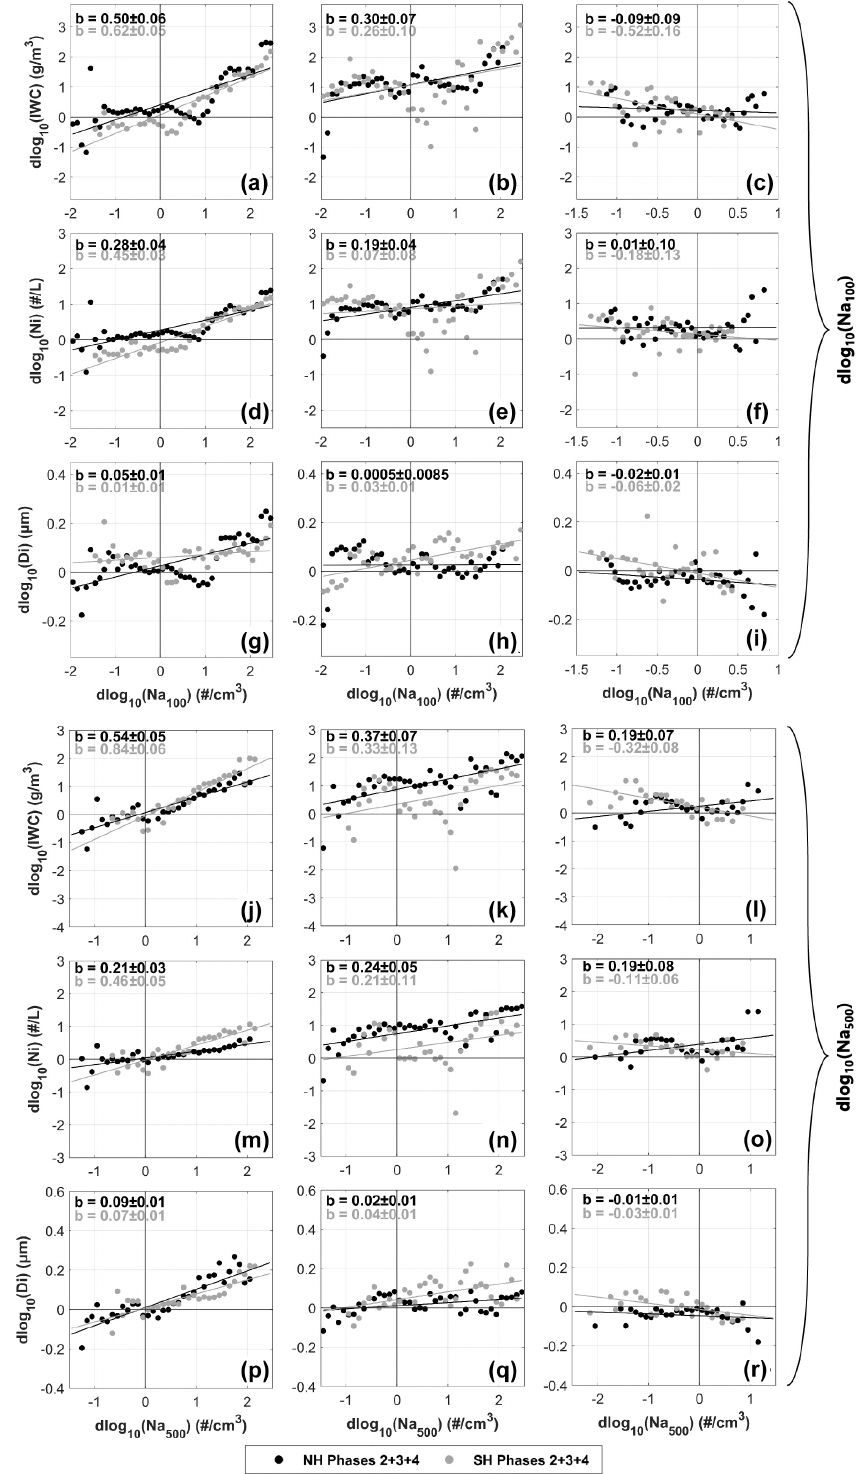
Figure 15. Linear regression of log 10 (IWC), log 10 (Ni) and Di with respect to the aerosol number concentrations, (top three rows) Na 100 and (bottom three rows) Na 500 . This analysis shows the combined phases 2, 3 and 4, separated by NH and SH. Columns 1, 2 and 3 represent 1Hz observations, 100km scale observations and CAM6 simulations, respectively. The number of samples is shown in the Supplement (Fig. S4).